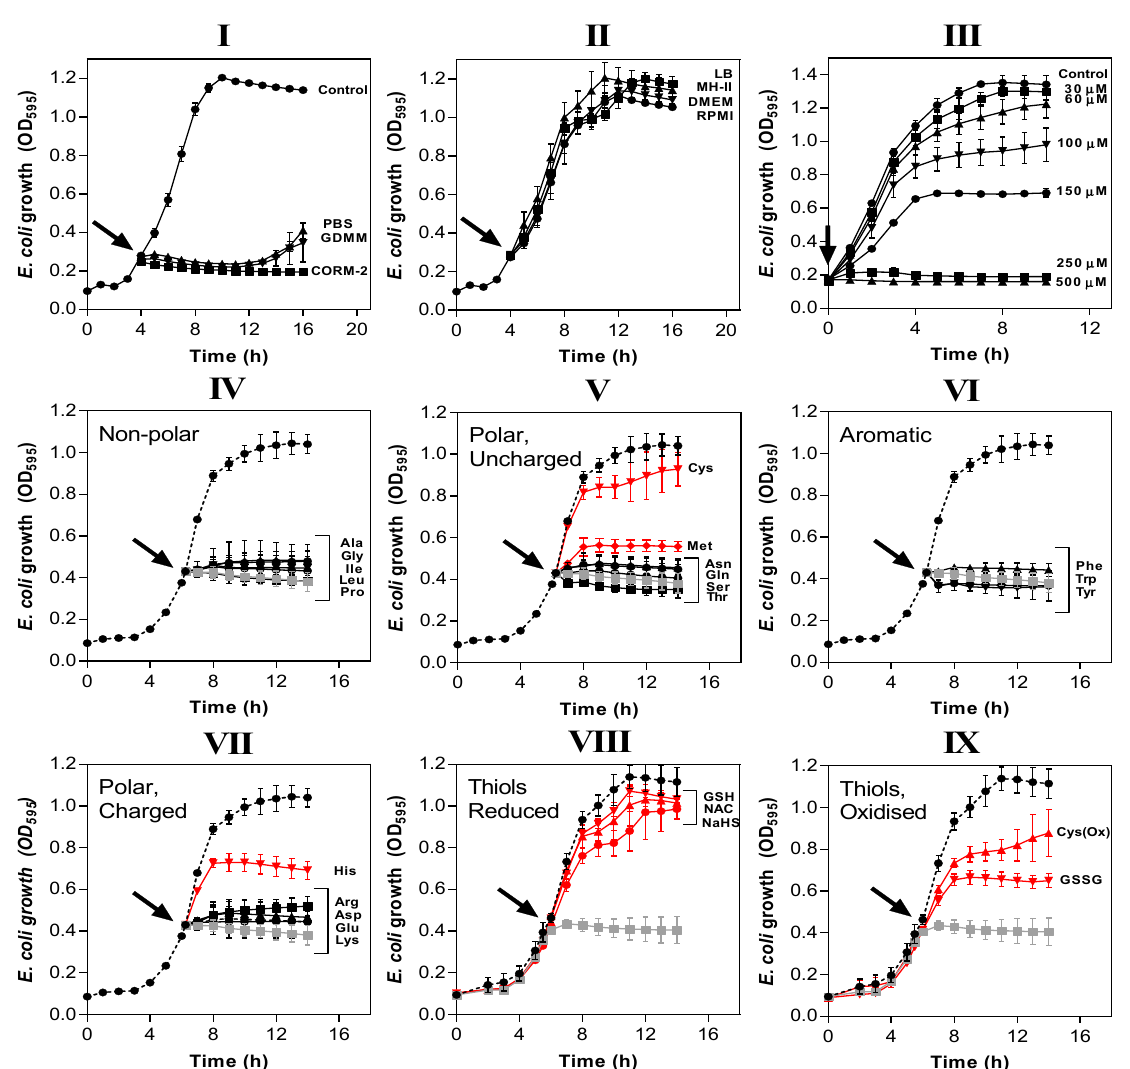
Figure 4. The potency of CORM-2 is influenced by certain compounds added to the growth medium. ( I , II ) CORM-2 stocks were prepared by dilution in 10% DMSO/90% H 2 O (‘CORM-2 ′ ) or diluted in 10% DMSO/90% medium: ( I ) minimal salts-based media (phosphate-buffered saline, PBS, glucose-defined minimal medium, GDMM) or ( II ) rich nutrient broths (lysogeny broth, LB, Mueller-Hinton II, MH-II, Dulbecco’s modified Eagle medium, DMEM or Roswell Park Memorial Institute medium, RPMI) and left to incubate for 10 min. These stocks were then added at a CORM-2 concentration of 30 μ M to E. coli grown on GDMM (arrow). Growth (OD 595 ) was monitored thereafter. Rich growth media ( II ) protected cells from the growth inhibitory effects of 30 μ M CORM-2. In ( III ), cultures grown on GDMM were supplemented with 0.25% ( w / v ) casamino acids, and 0–500 μ M CORM-2 was added to determine whether a mixture of extracellular amino acids protects against CORM-2-mediated growth inhibition. To determine which specific components of rich media were responsible for protective effects against CORM-2-induced growth inhibition, CORM-2 stocks were mixed with a 2-fold excess of ( IV ) non-polar amino acids, ( V ) polar, uncharged amino acids, ( VI ) aromatic amino acids, ( VII ) polar charged amino acids, ( VIII ) reduced thiol compounds (N-acetyl cysteine, NAC, reduced glutathione, GSH, sodium hydrosulphide, NaHS) or ( IX ) oxidised thiol compounds (cystine, OxCys, oxidised glutathione, GSSG). These stocks were then added to E. coli cells grown on GDMM and growth was monitored relative to no-CORM controls (dashed line) and 30 μ M CORM-2 prepared by dilution in 10% DMSO/90% H 2 O as standard (grey line). The lines in red indicate amino acids/sulphur compounds that protect against the growth inhibitory effects of 30 μ M CORM-2, whereas black lines indicate that the compounds did not exert protective effects. All data are representative of 3–4 biological repeats ± SD.